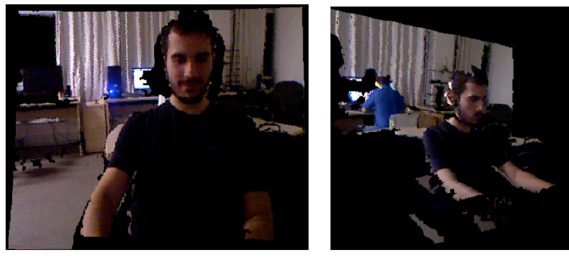
Figure 12 – Frontal view (left) and side view (right) of the point cloud.